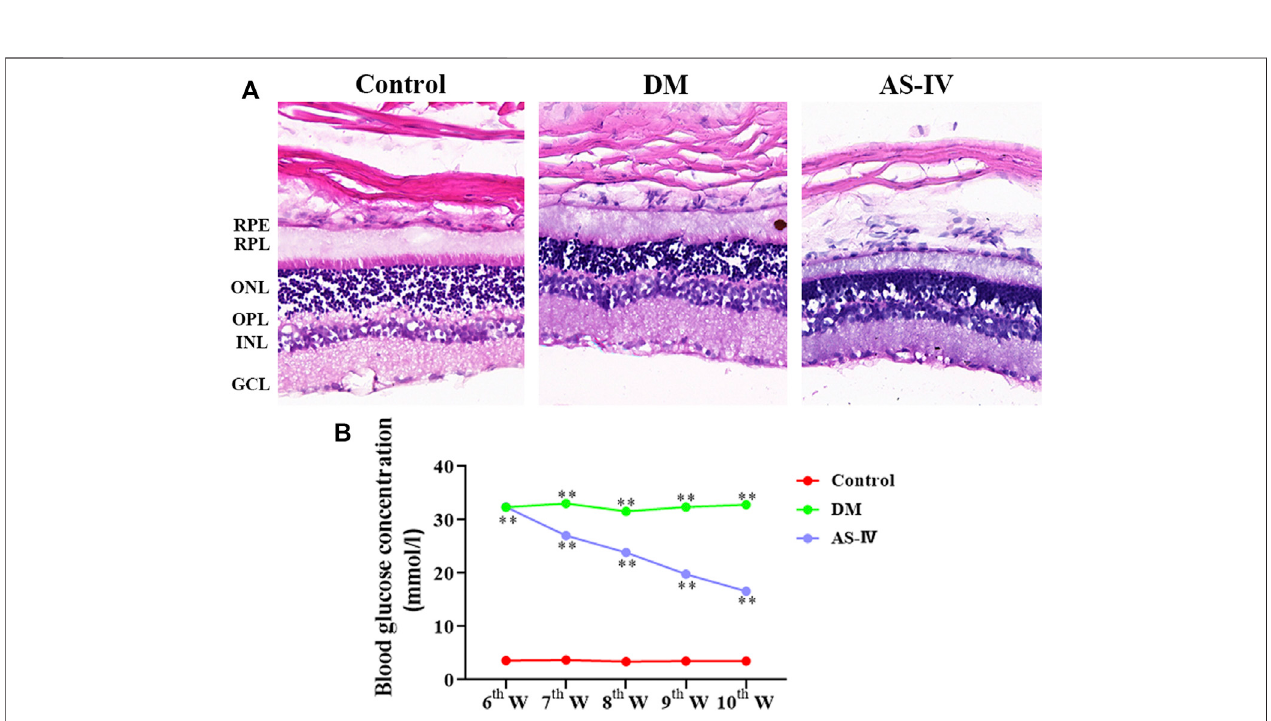
FIGURE3 | Effectsof AS-IV on histopathological changes and blood glucose levels ofrats after DR. (A) HE stainingimagesofretinaltissuesin rats among control, DM and AS-IV groups. Scale bar = 200 μ m. (B) Blood glucose levels variation of rats in control, DM and AS-IV treatment groups. RPL, retinal photoreceptor layer; RPE, retinal pigment epithelium; ONL, outer nuclear layer; GCL, ganglion cell layer; INL, inner nuclear layer; OPL, outer plexiform layer; DM, diabetes mellitus; AS-IV, astragaloside IV; w, weeks. ** p < 0.01.